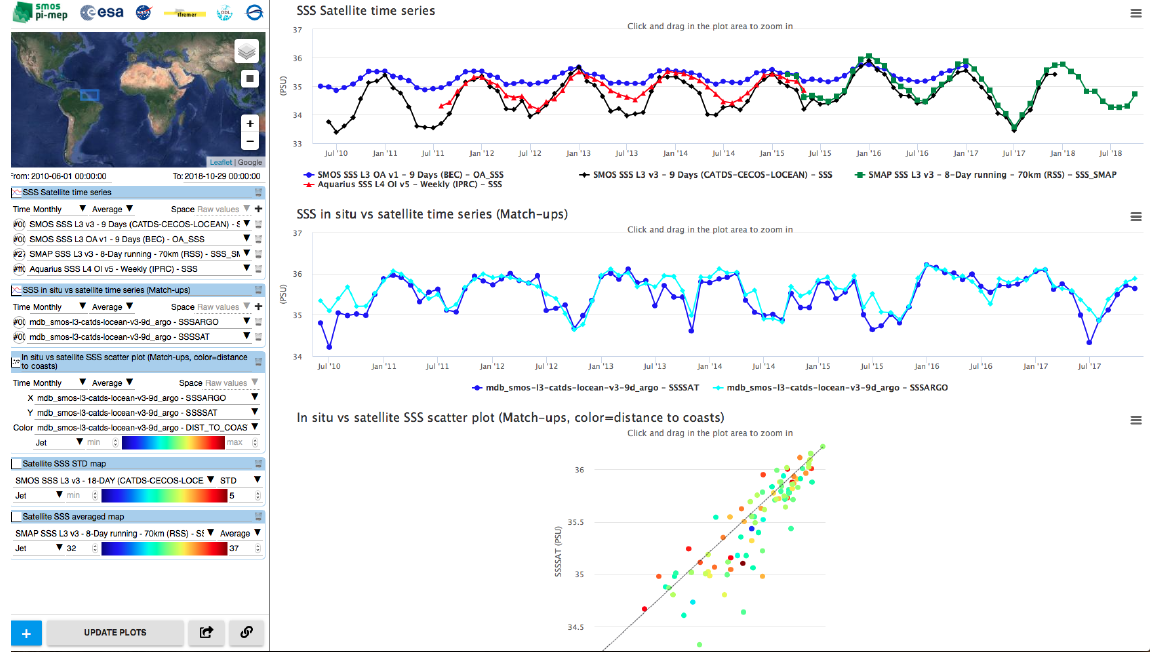
Figure 15. Illustration of the plot interface: The left side contains the controls (selection of an area on the map and a time period, the satellite/in situ products to be analyzed) and the right side contains the resulting plots.